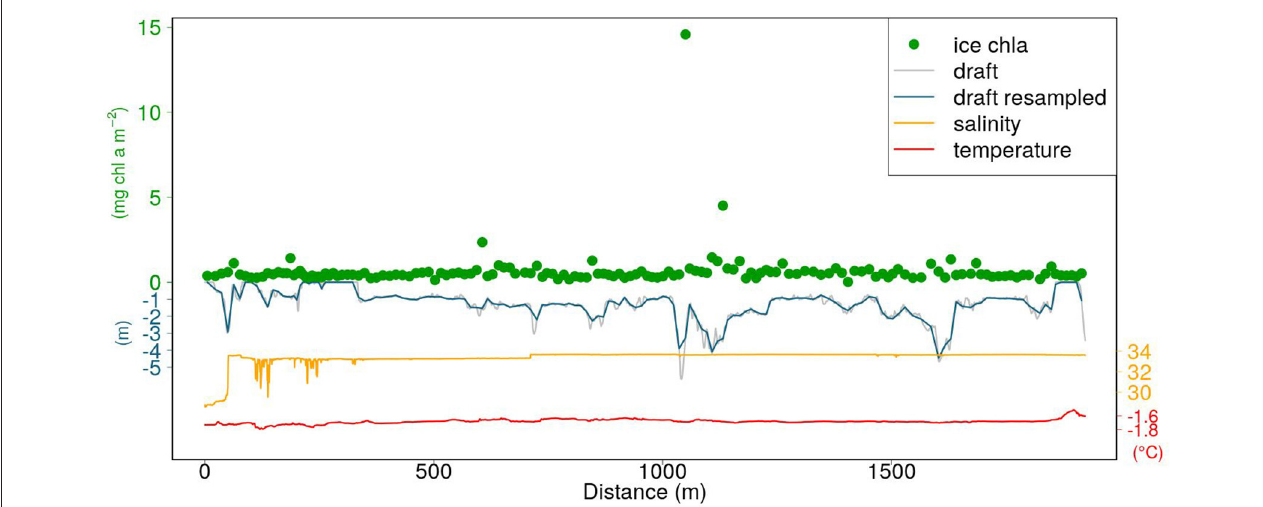
FIGURE 4 | Example of a SUIT profile (station PS92-47_1). Orange and red lines represent surface salinity and temperature, respectively. The gray line is the draft obtained with Equation (1). The blue line is the draft resampled at the frequency of the RAMSES radiometers sampling (section 2.4). The green circles represent in-ice chl a retrieved by applying the NDI algorithm c in Table 2